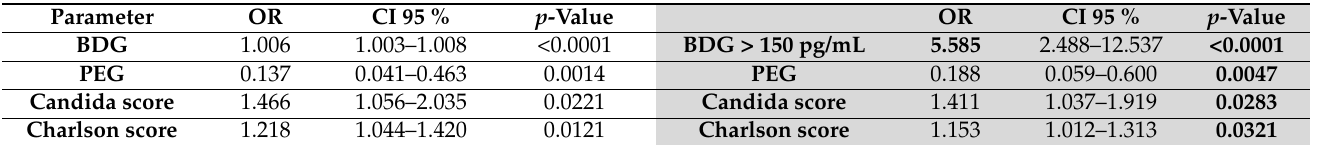
Table 3. Risk factors for candidemia in Internal Medicine Ward